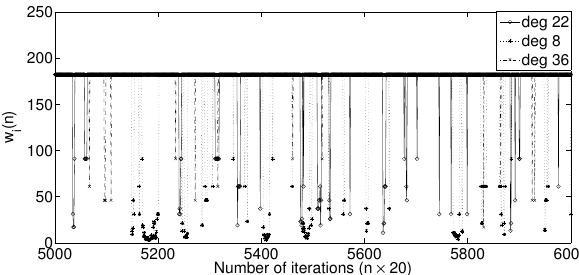
Figure 7: Steady state w i ( n ) vs n for nodes with maximum and minimum degrees and for a node with degree close to the average